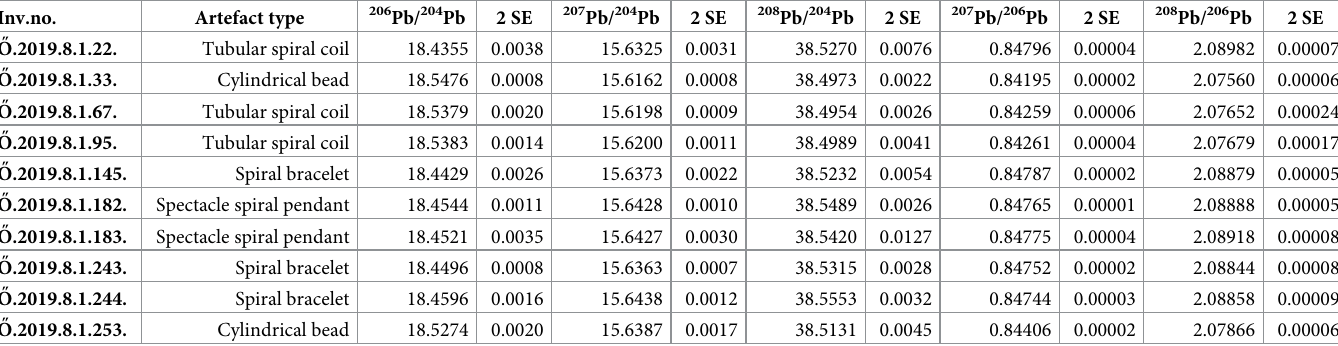
Table 3. Lead isotope abundance ratios of copper artefacts from the hoard of Magyaregres.